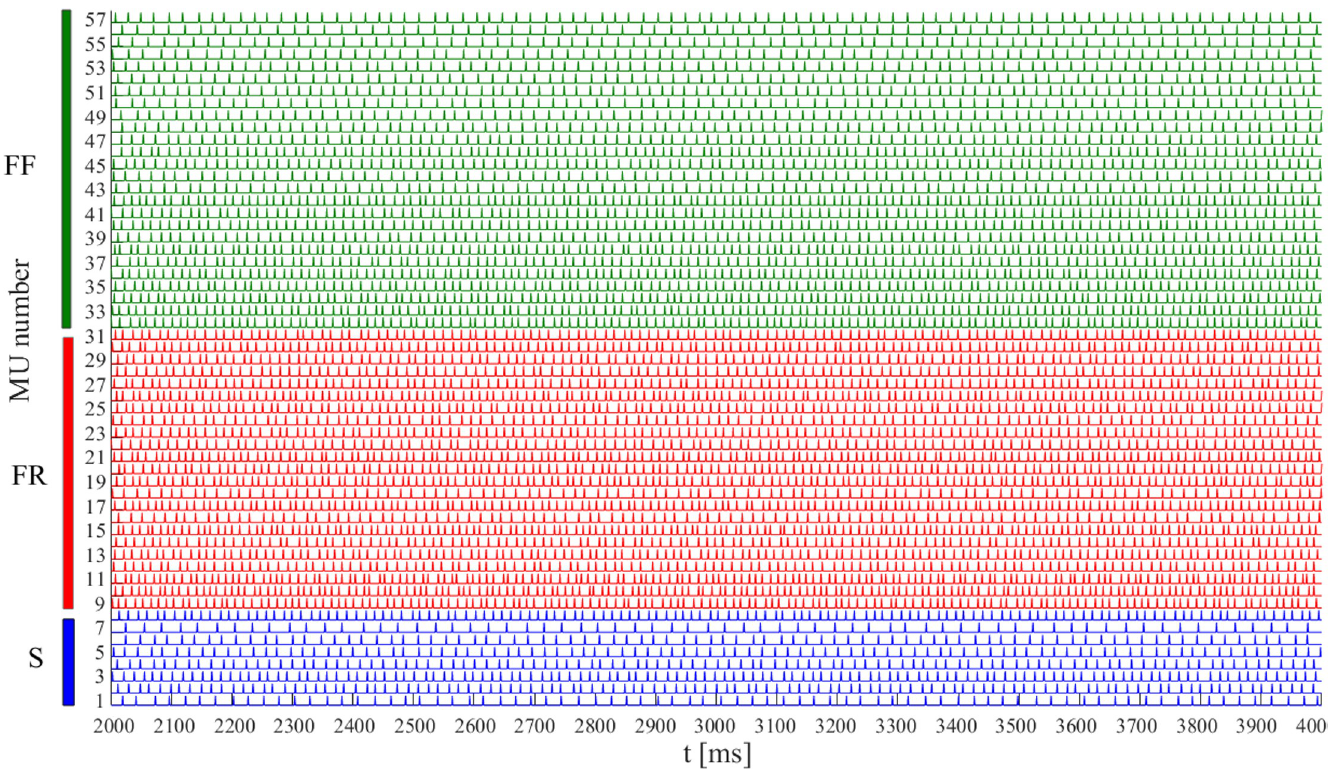
Fig 2. Firing patterns of 57 MU of the basic NS model during the time period of 2000 to 4000 ms. MUs are numbered in an ascending order based on their maximum twitch forces within each type: S (1–8), FR (9–31), and FF (32–57).